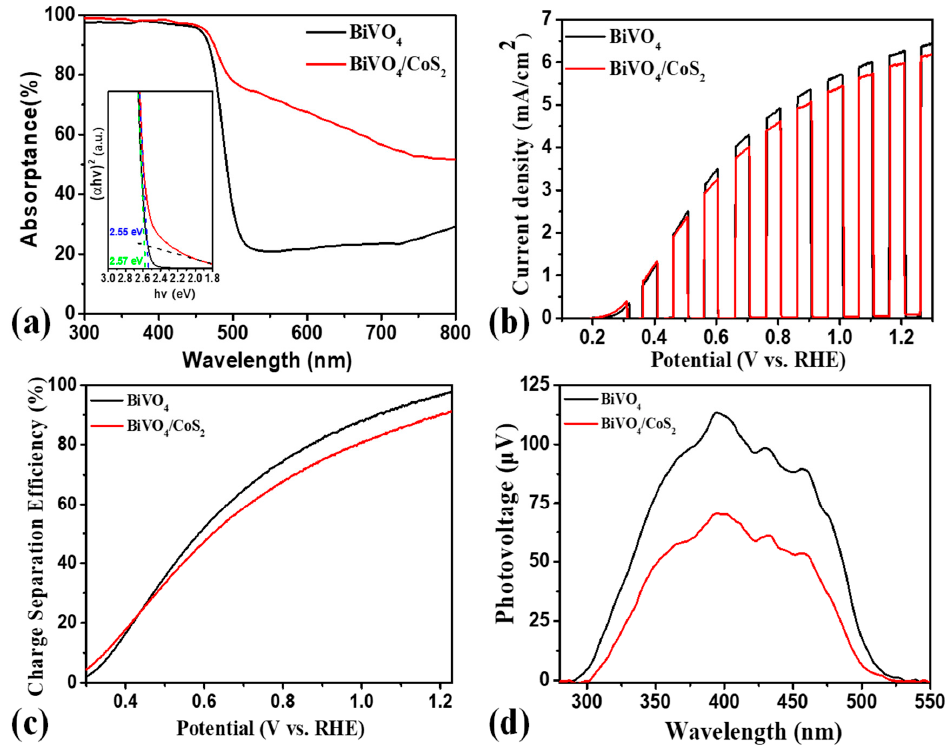
Figure 4. ( a ) UV–Vis spectra of the bare BiVO 4 and BiVO 4 /CoS 2 photoanodes. ( b ) J–V curves of the bare BiVO 4 and BiVO 4 /CoS 2 photoanodes measured under chopped AM 1.5G illumination. A 0.25 M K 2 B 4 O 7 buffer solution (pH = 9.5) with the addition of 0.2 M sodium sulfite was used as the electrolyte. ( c ) Derived bulk charge separation efficiencies of BiVO 4 and BiVO 4 /CoS 2 . ( d ) Surface photovoltage spectroscopy of the bare BiVO 4 and BiVO 4 /CoS 2 photoanodes.